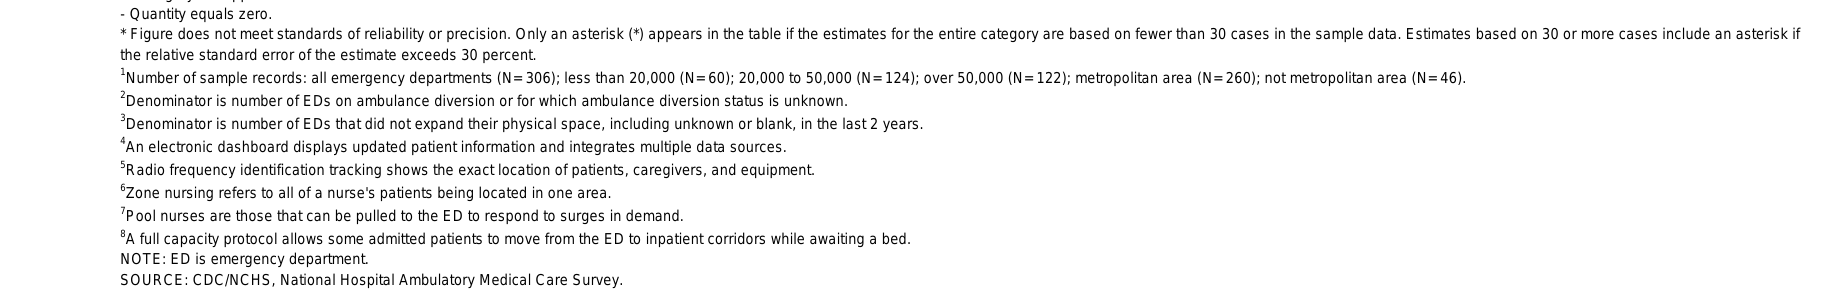
* Figure does not meet standards of reliability or precision. Only an asterisk (*) appears in the table if the estimates for the entire category are based on fewer than 30 cases in the sample data. Estimates based on 30 or more cases include an asterisk if the relative standard error of the estimate exceeds 30 percent. 1 Number of sample records: all emergency departments (N= 306); less than 20,000 (N= 60); 20,000 to 50,000 (N= 124); over 50,000 (N= 122); metropolitan area (N= 260); not metropolitan area (N= 46). 2 Denominator is number of EDs on ambulance diversion or for which ambulance diversion status is unknown. 3 Denominator is number of EDs that did not expand their physical space, including unknown or blank, in the last 2 years. 4 An electronic dashboard displays updated patient information and integrates multiple data sources. 5 Radio frequency identification tracking shows the exact location of patients, caregivers, and equipment. 6 Zone nursing refers to all of a nurse's patients being located in one